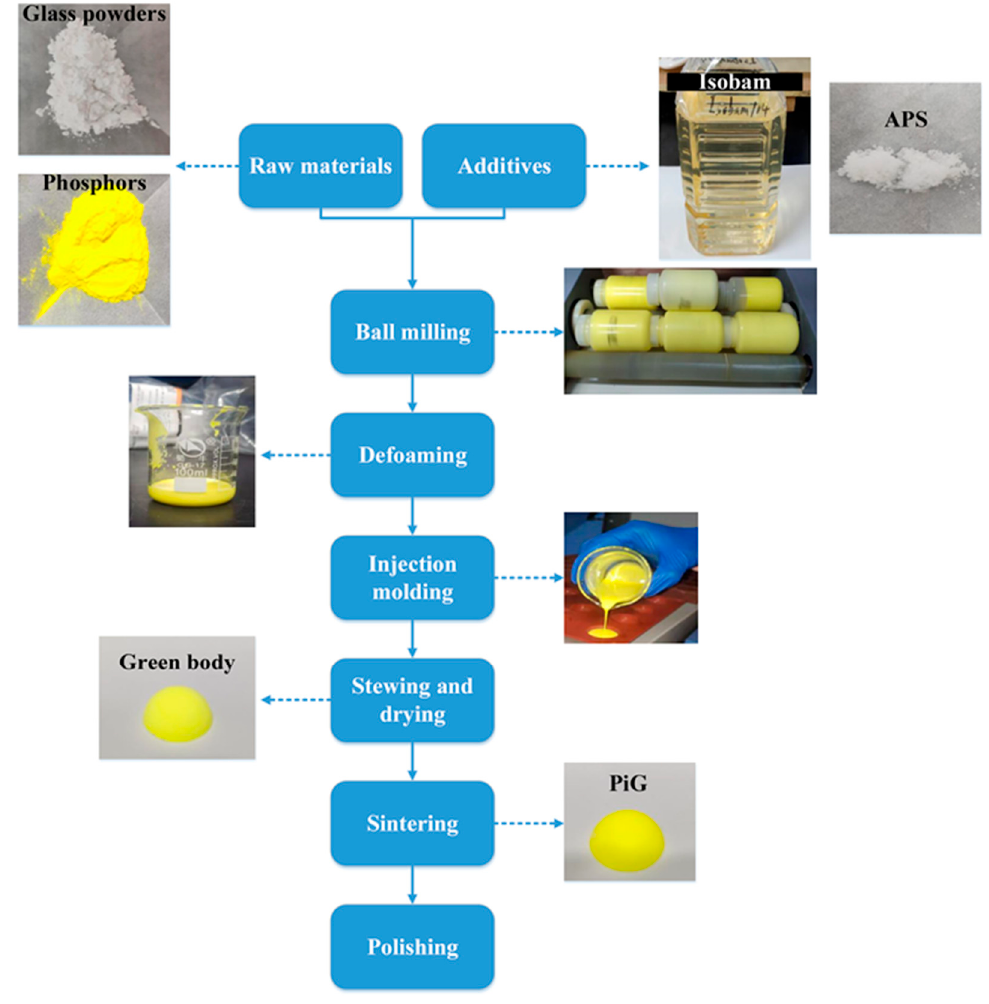
Figure 1. Process for preparing PiGs by gel casting with Isobam. Table 1. Composition of samples with different ratios of phosphors and glass powders.